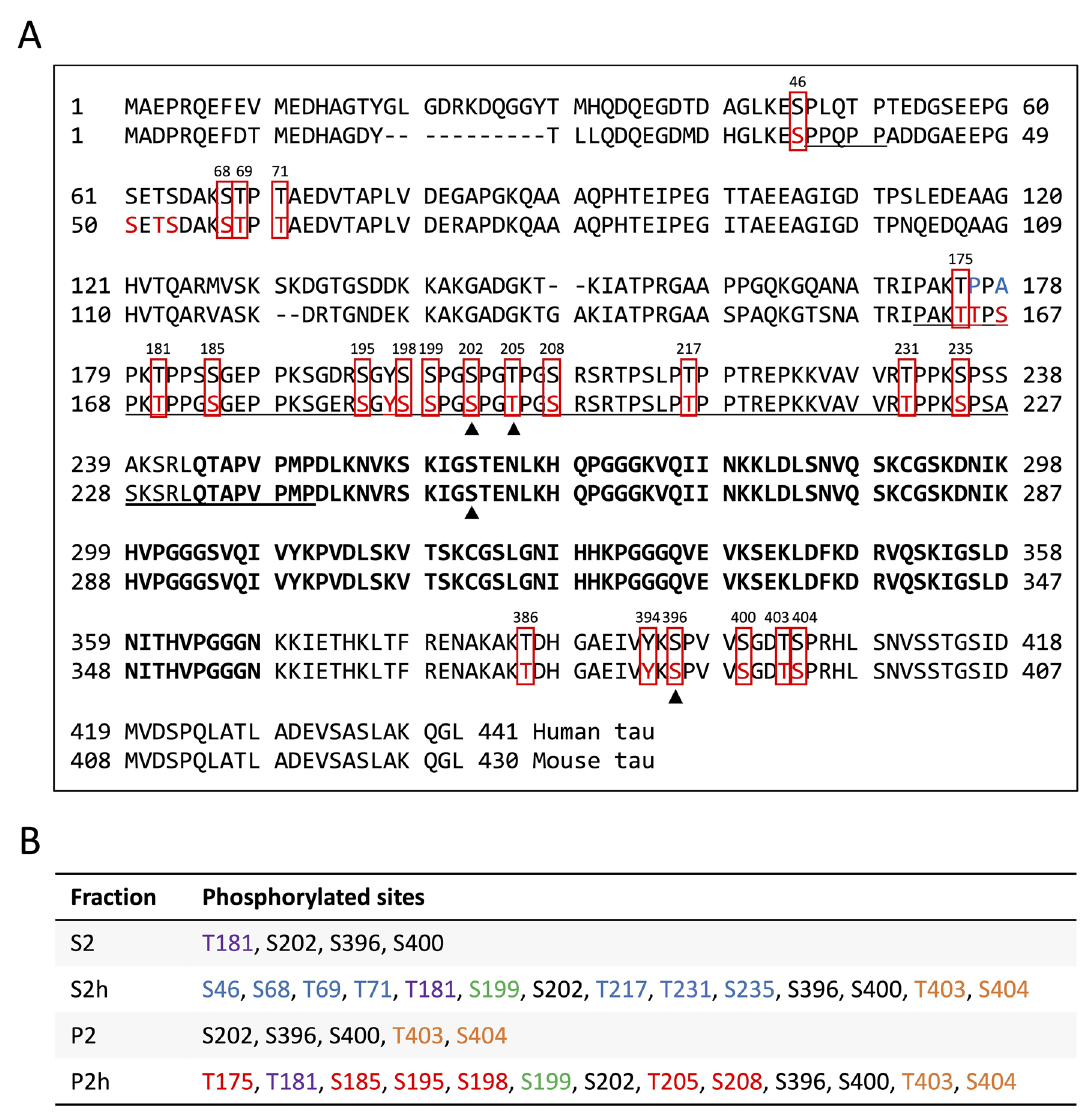
Figure 5. Tau phosphorylation sites identified in this study. (A) Alignment of 441-residue human tau and 430-residue mouse tau sequences with identified phosphorylation sites. Phosphorylated sites of mouse tau detected by LC–MS/MS in this study are marked in red. The red boxes indicate conserved phosphorylation sites in human tau. Nonconserved phosphorylation sites in human is marked in blue. Arrowheads indicate the phosphorylation sites we tested by Western blot. Bolded letters show the repeat domains (244–368 aa). Underlined regions indicate the LCRs analyzed by PlaToLoCo. (B) Phosphorylated sites of tau identified in each fraction. The phosphorylated sites specifically identified in S2h and P2h are marked in blue and red, respectively. The phosphorylated sites shared in all fractions are marked in black, and those shared between S2, S2h and P2h are marked in purple. The phosphorylated sites shared between S2h and P2h are marked in green, and those shared between S2h, P2 and P2h are marked in